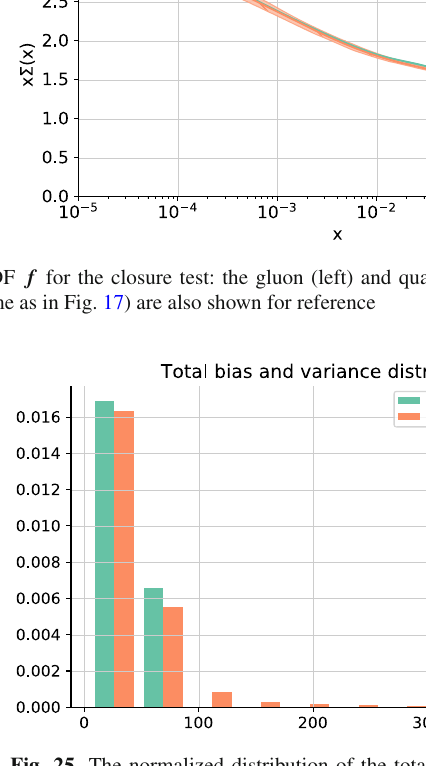
Fig. 25 The normalized distribution of the total bias, Eq. (6.7), and of total variance, Eq. (6.8), over the n fits constituting the NNPDF4.0 closure tests. The square root of the mean of these two distributions defines